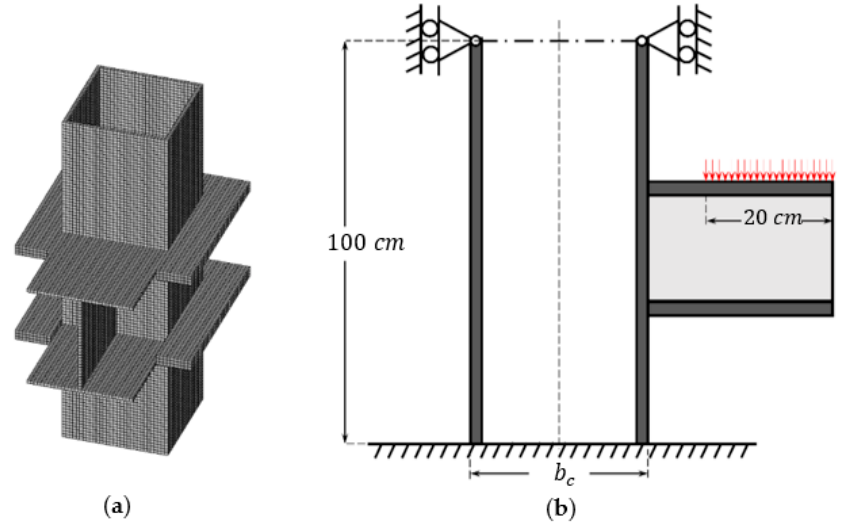
Figure 4. HSS column in an IBBC area—( a ) pre-retrofitting, ( b ) post-retrofitting.